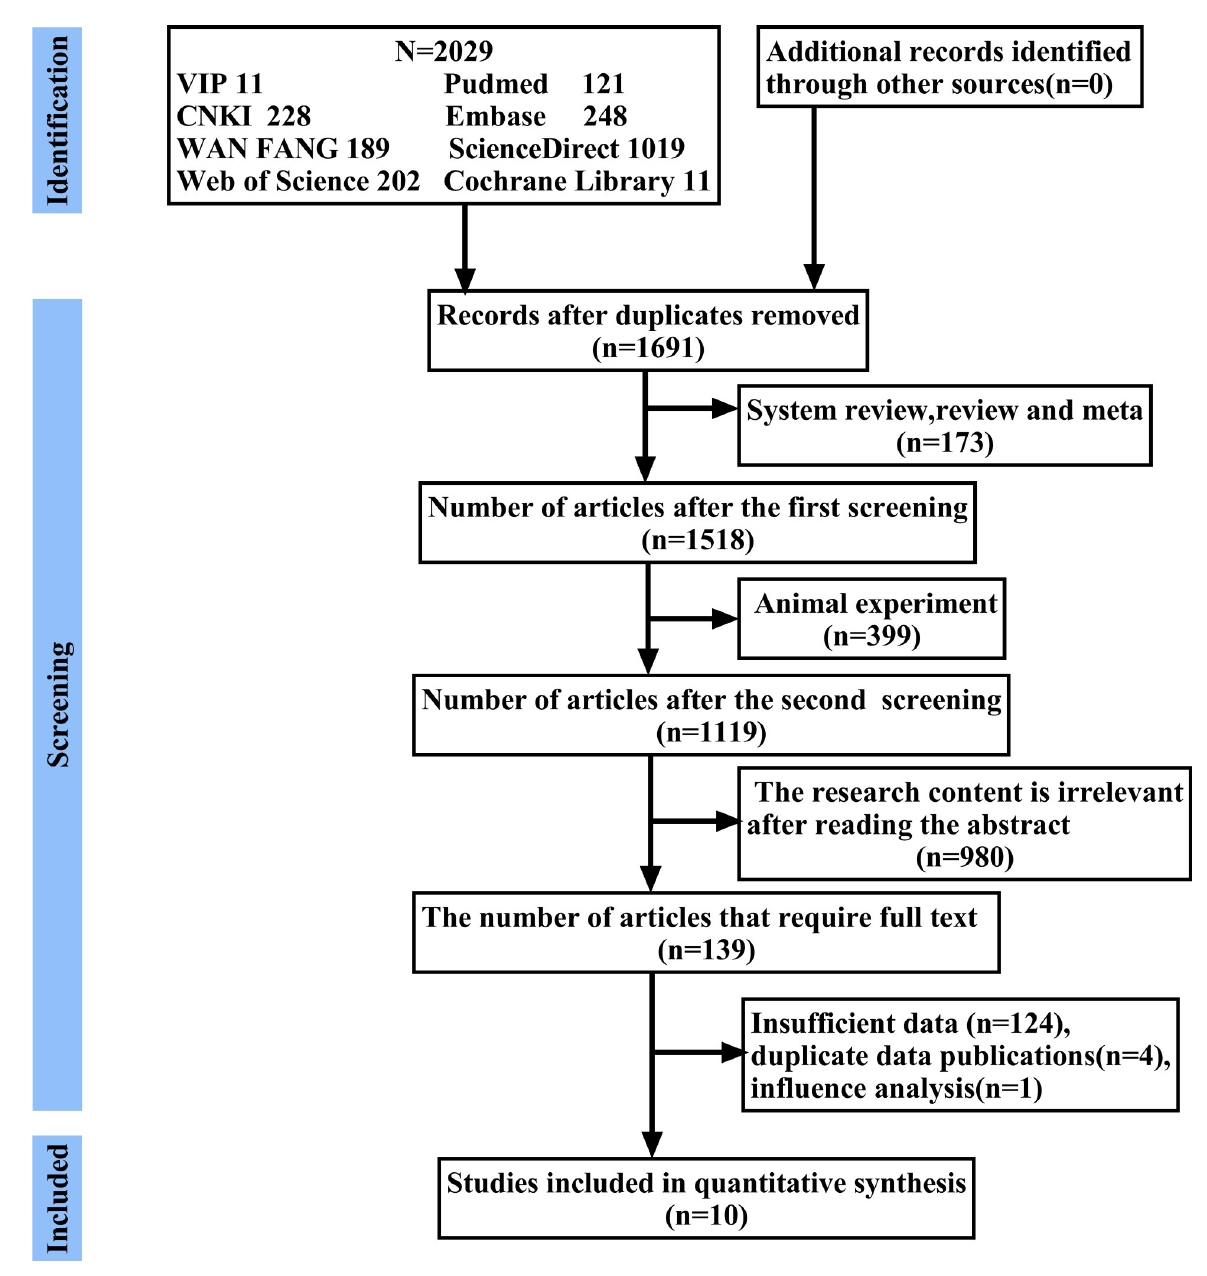
Fig 1. Flow chart of search